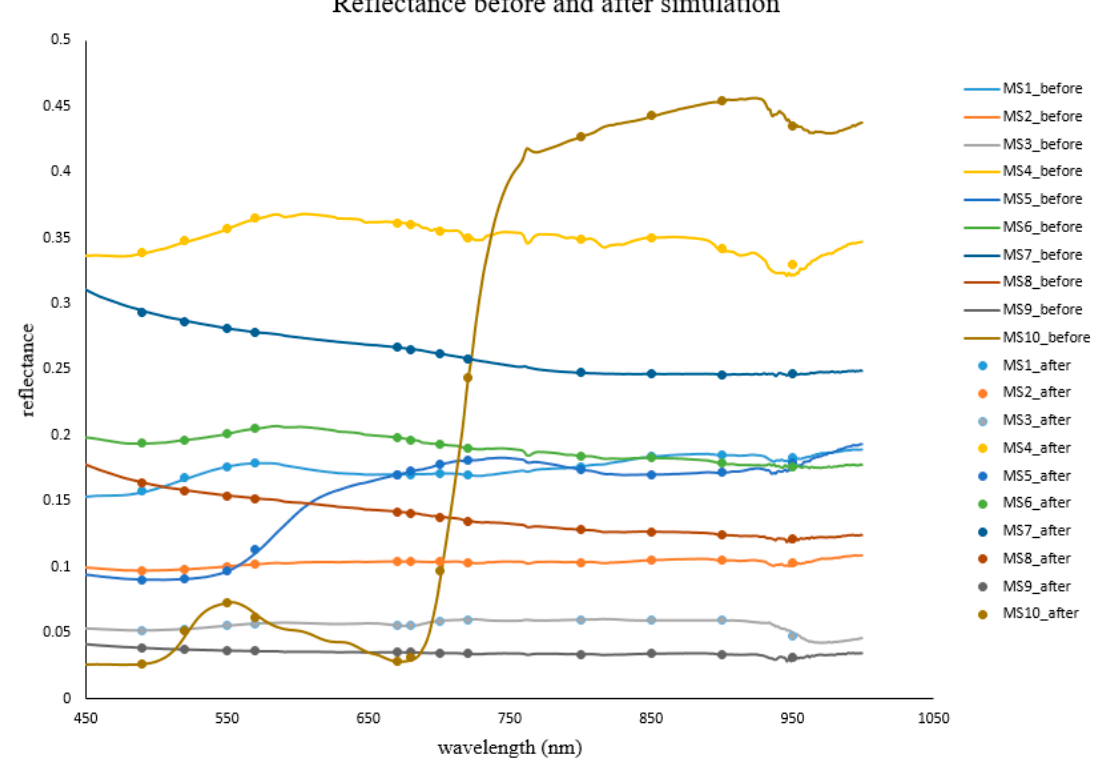
Figure 7. Reflectance before and after simulation.